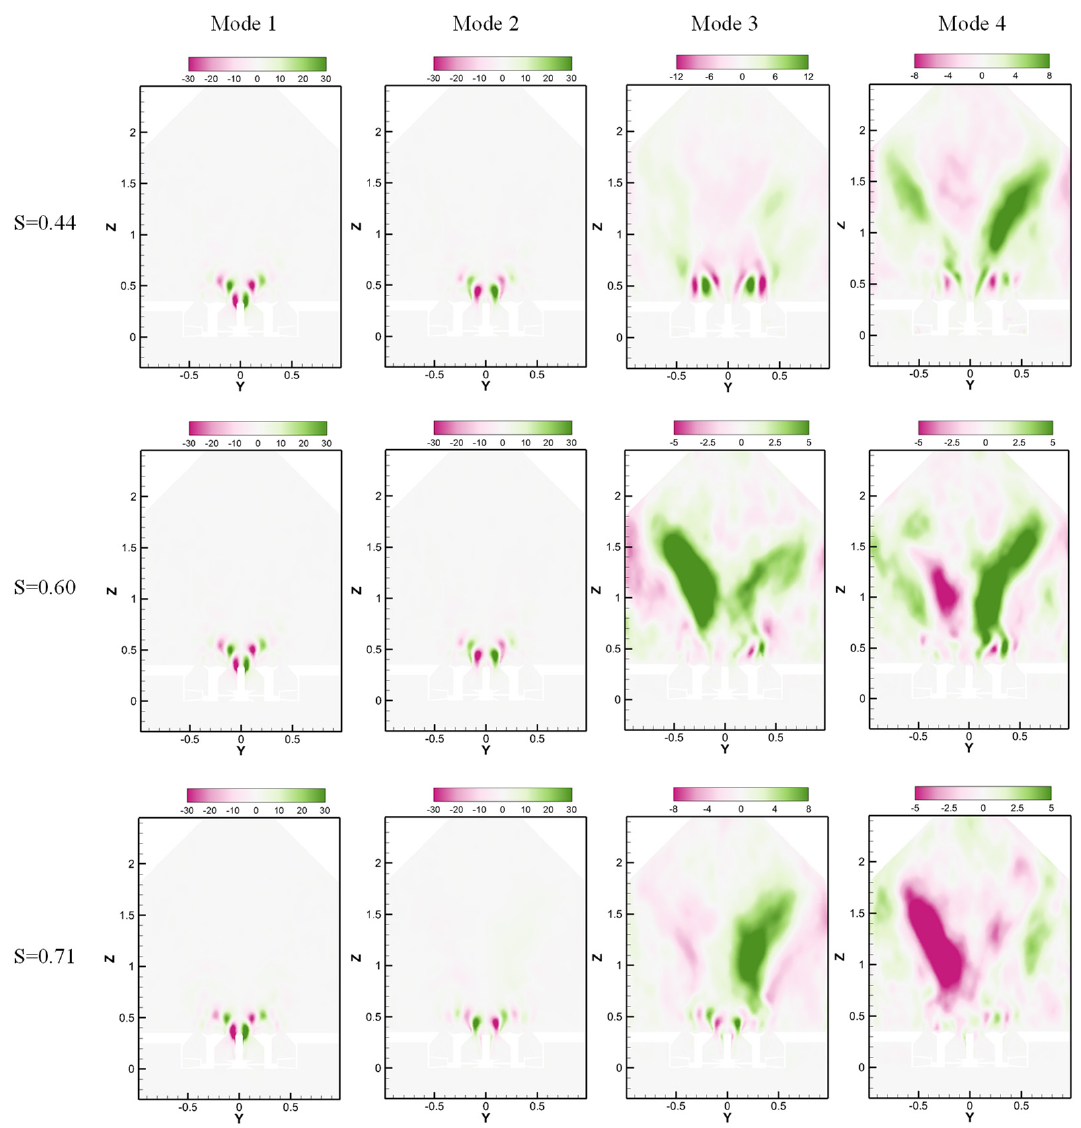
Figure 12. The spatial distribution of the first four modes by POD.